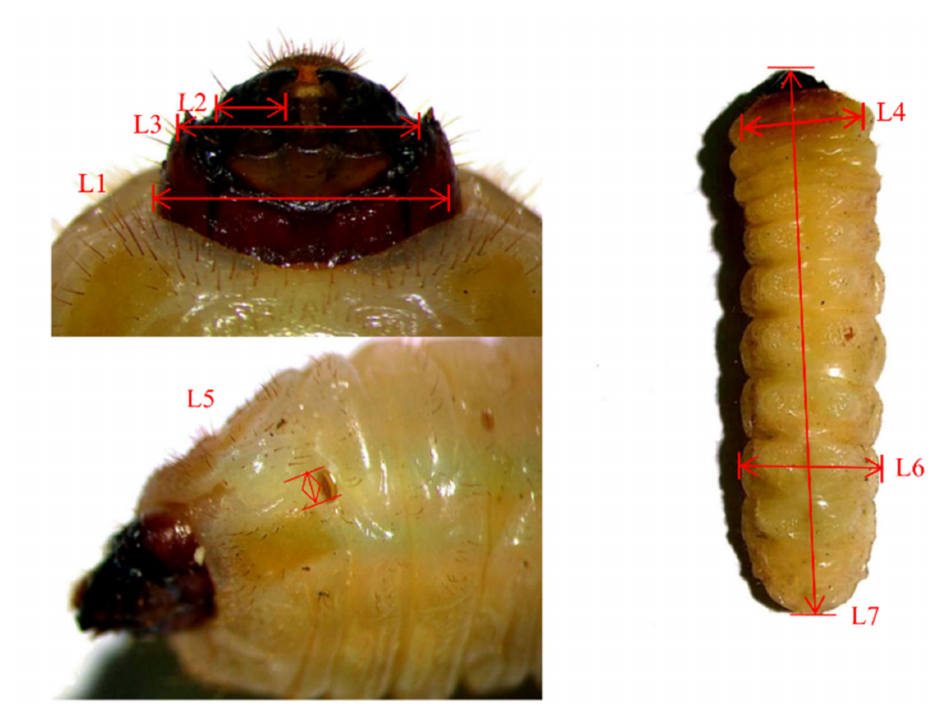
Figure 1. Seven variables measured for distinguishing instars of M. saltuarius larvae. (L1) Head capsule width, (L2) mandible length, (L3) distance between the main ocelli, (L4) prothoracic plate width, (L5) mesothoracic spiracle length, (L6) body width, (L7) body